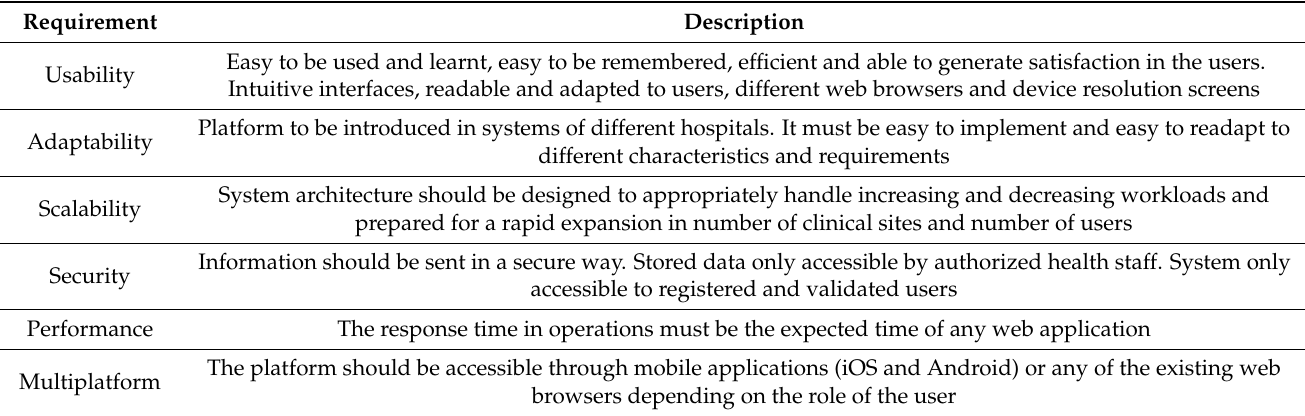
Table 2. Summary of the main EmERGE platform nonfunctional requirements.